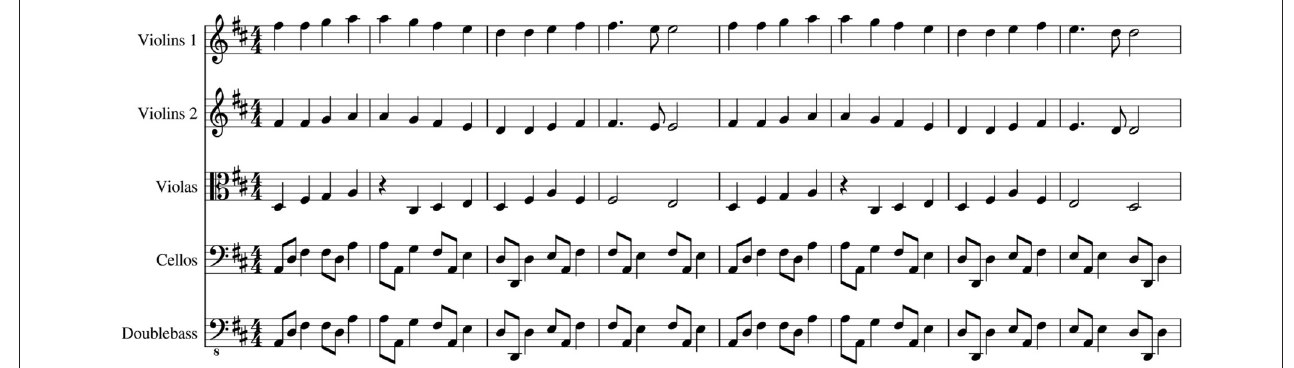
FIGURE 2 | Excerpt from Beethoven’s 9th symphony used in the